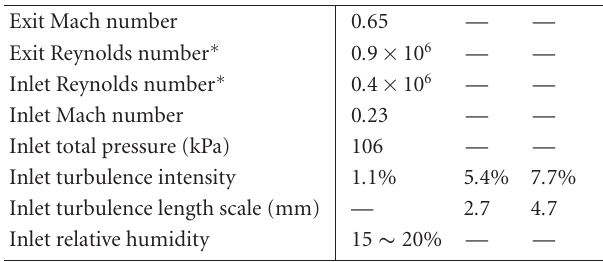
Table 1: Experimental operating conditions. Table 2: Test airfoil geometric